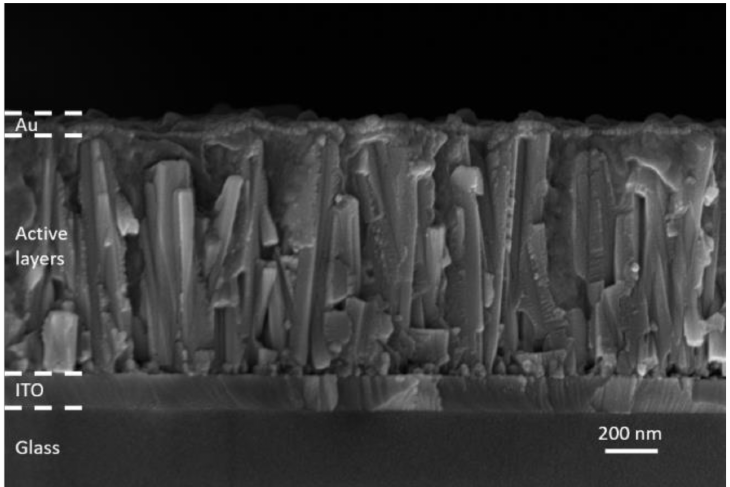
Figure 7. Cross-sectional view FESEM image of the complete ETA solar cell structure of ITO/ZnO/TiO 2 /Sb 2 S 3 /P3HT/Au when using the cycle number of 70. The J – V curves collected in dark and AM 1.5 G illumination conditions are presented in Figure 8, and the photovoltaic properties are reported in Table 1 and plotted in Figure 9.